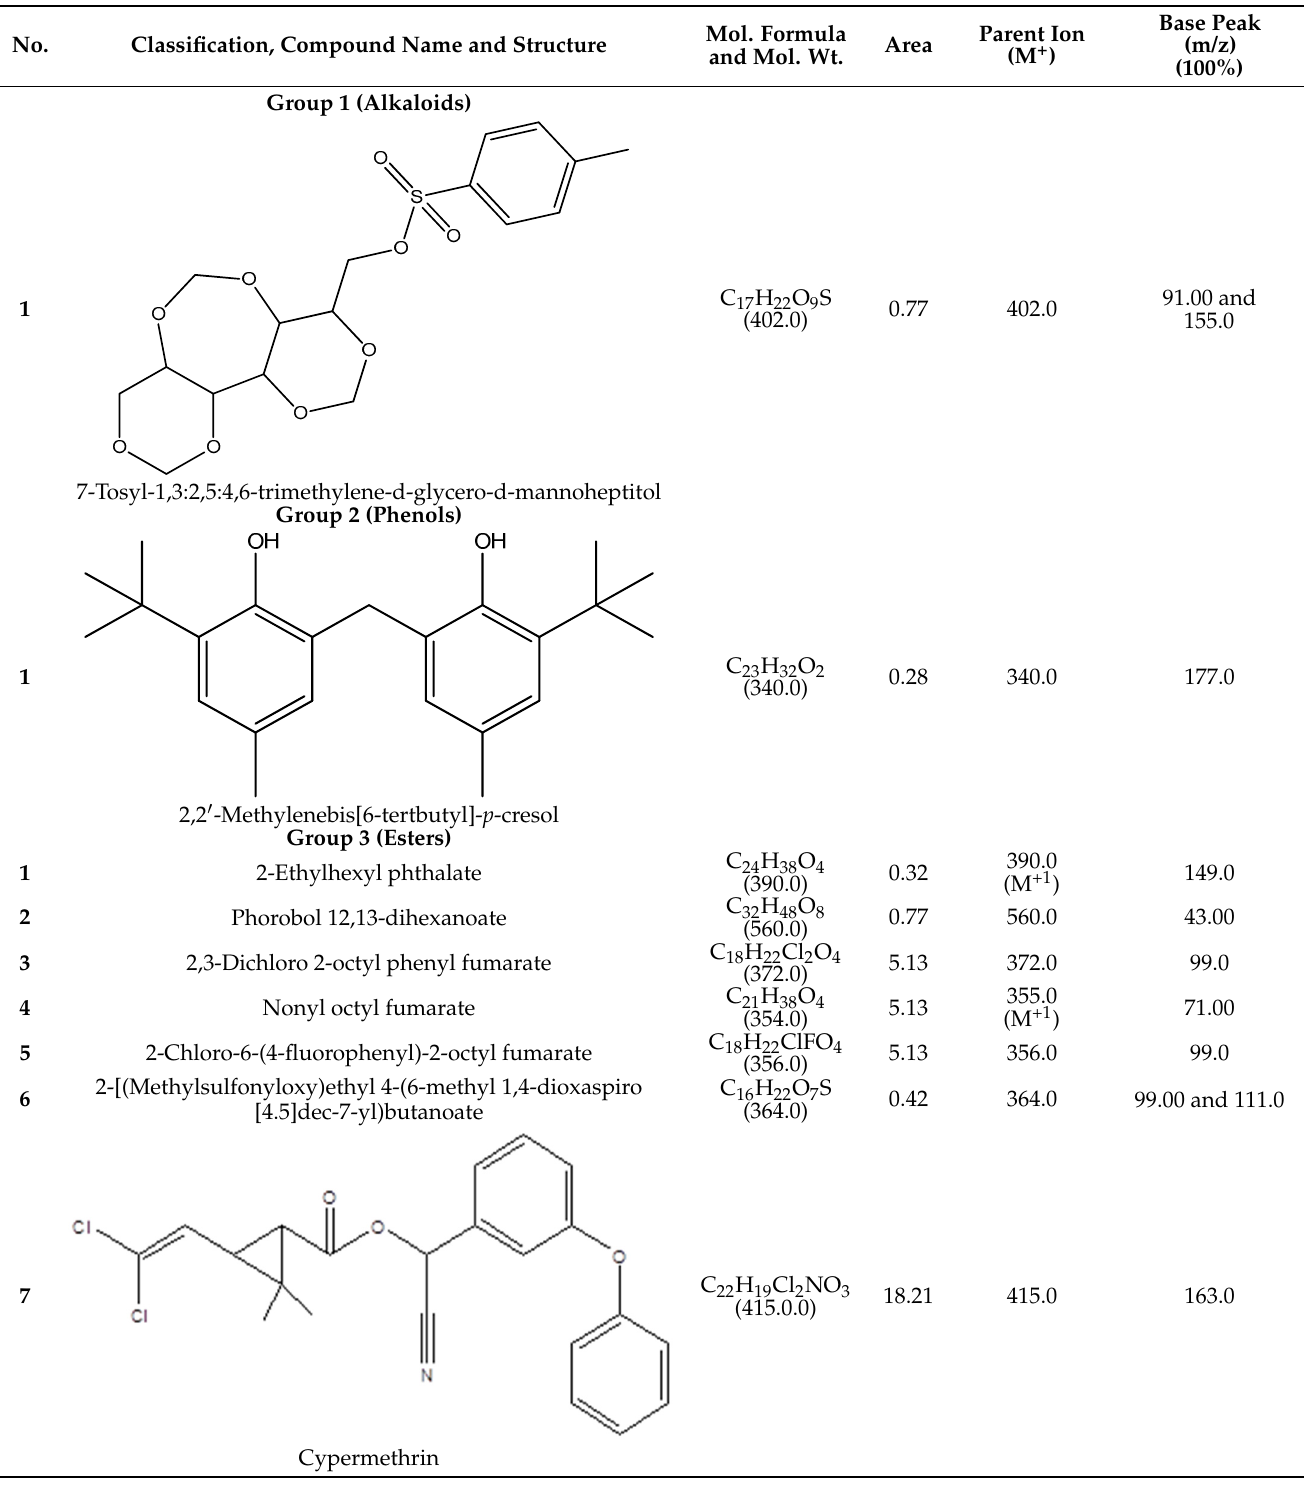
Table 1. Putative identification of the chemical components from KB when subjected to GC-MS (gas liquid chromatographic–mass spectrometry).